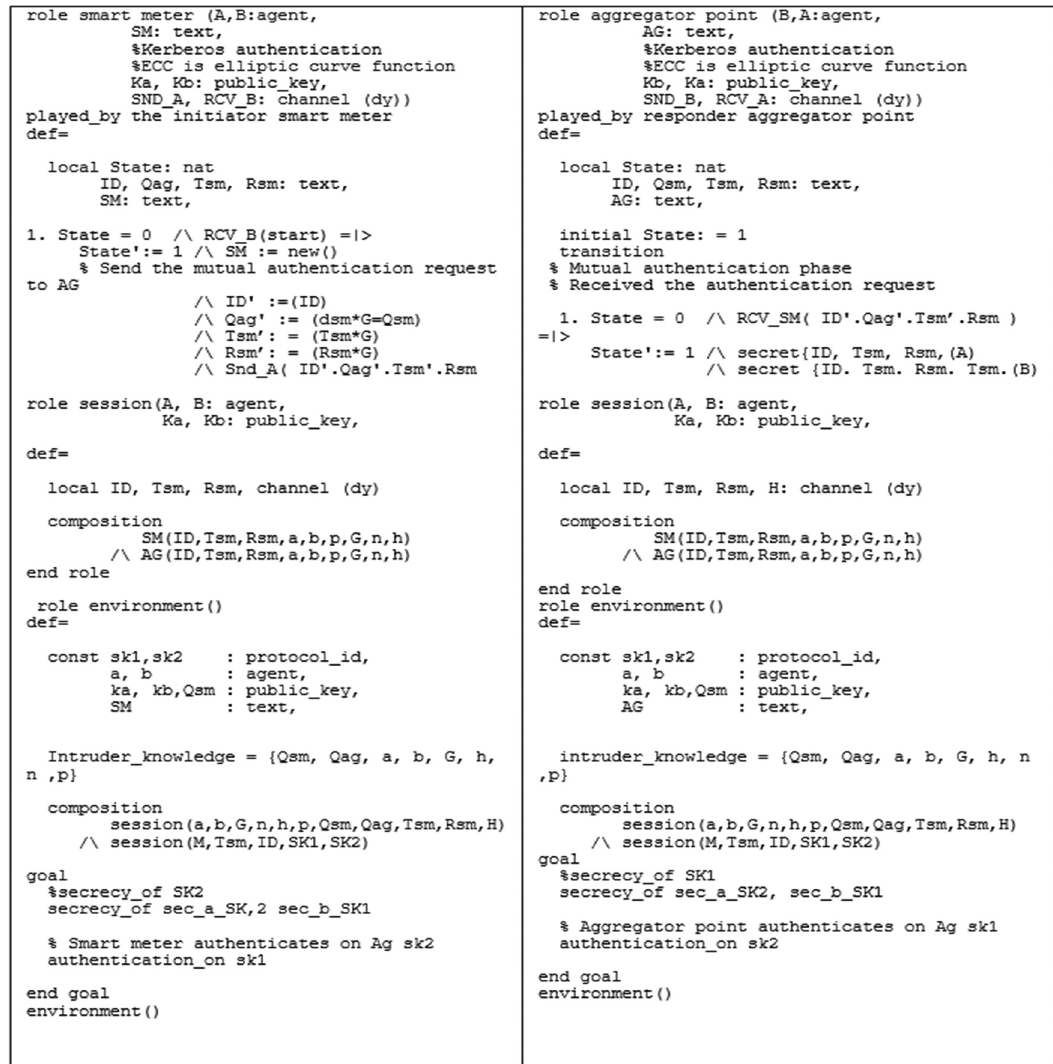
Figure 2: Role of HLPSL for smart meter and aggregator